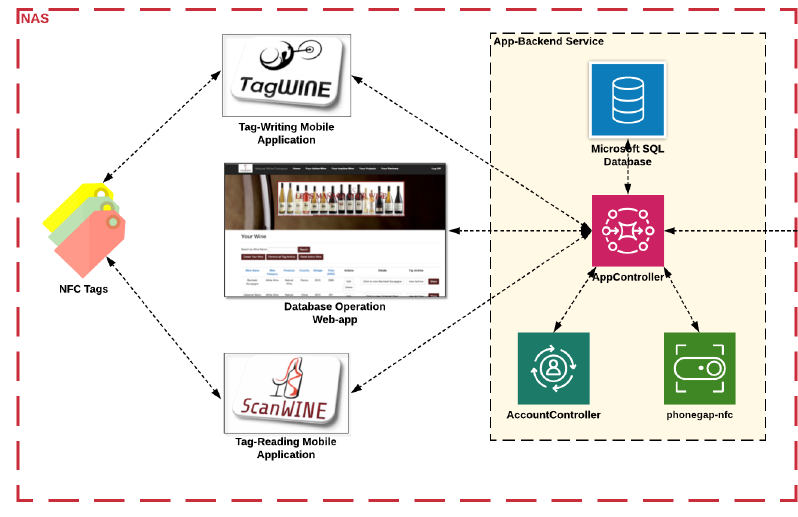
Figure 10. The System Components of Legacy